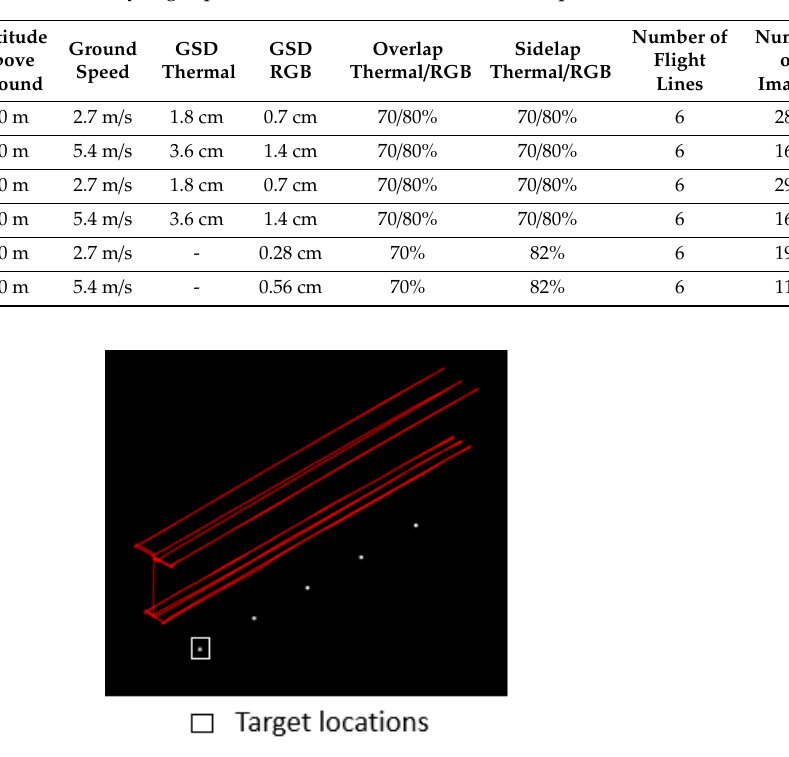
Figure 10. Trajectory and target locations for FLIR Duo Pro R and Sony Alpha 7R.